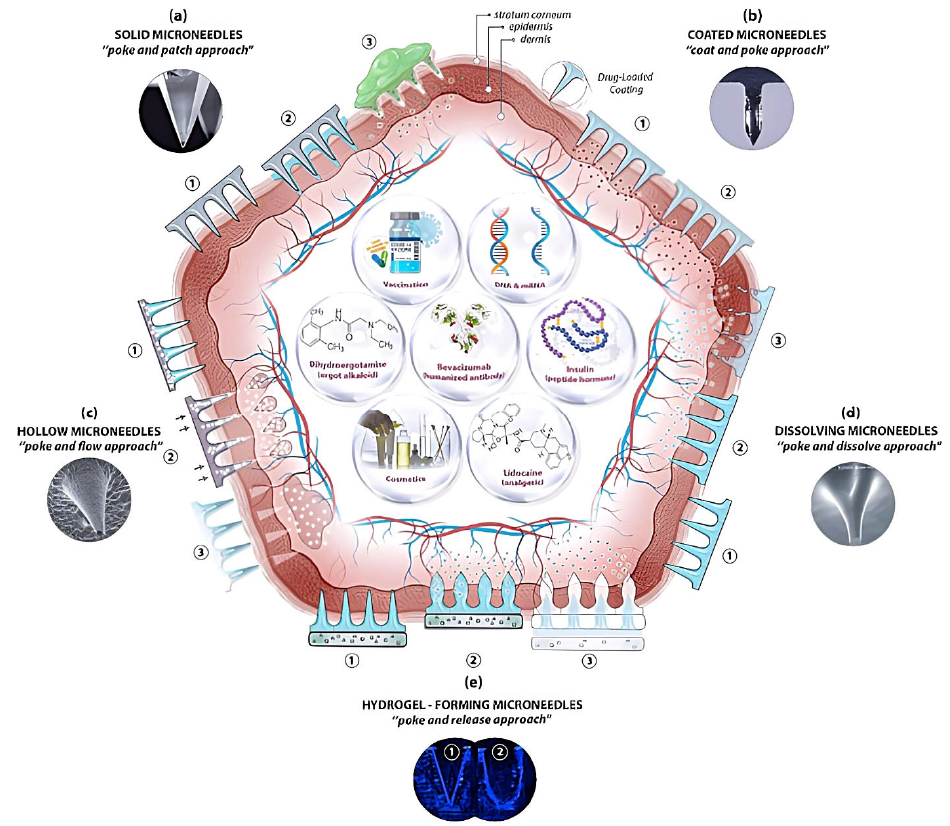
Figure 2. Schematic representation of microneedle-mediated transdermal drug delivery: ( a ) Solid microneedles, by creating transient hydrophilic microchannels in the skin, improve the drug per- meation. ( b ) Drugs are coated onto the microneedle surface and dissolve quickly once inserted into the skin. ( c ) Hollow microneedles penetrate the skin, allowing the injection of the drug solution. ( d ) Upon skin insertion, dissolving microneedles dissolve and release the drug payload into the skin layers. ( e ) Swelling microneedles absorb interstitial skin fluid and swell to enhance drug diffusion through the porous swollen structure. Images reprinted with permission from [69].